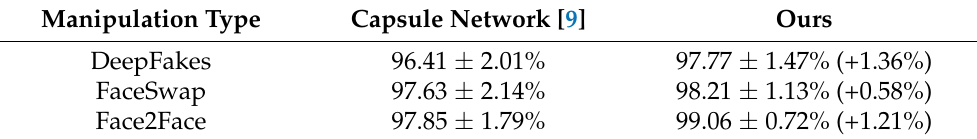
Table 1. Comparison of the accuracy and the uncertainty of the proposed method and the original capsule network on different manipulation types.